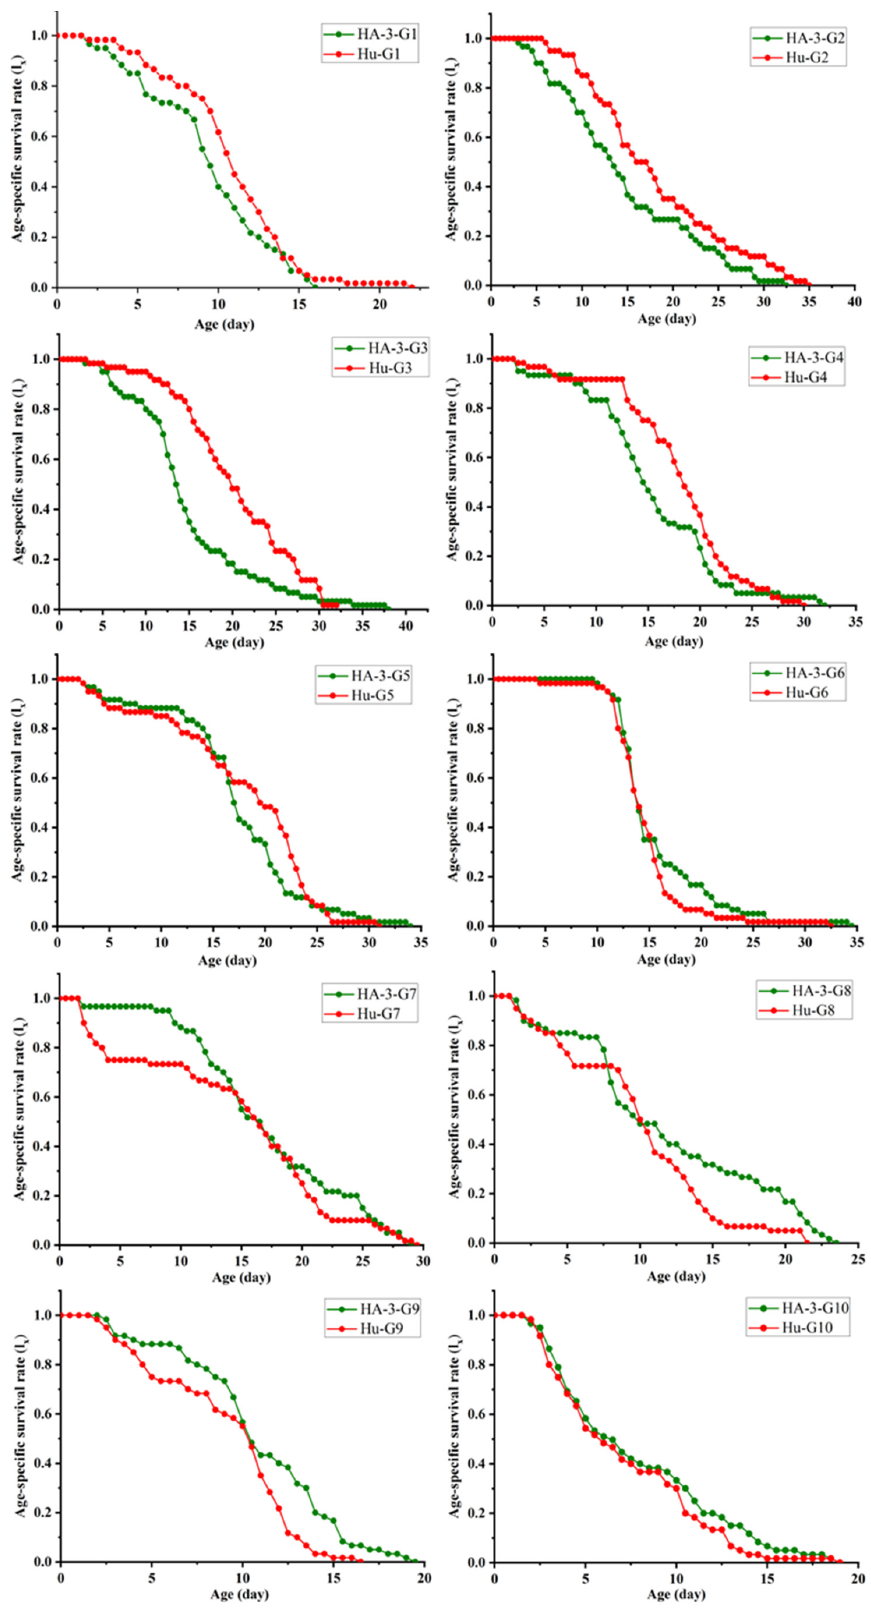
Figure 2. Age-specific survival rate of SAA G1-G10 on HA-3 and Hu cultivars.